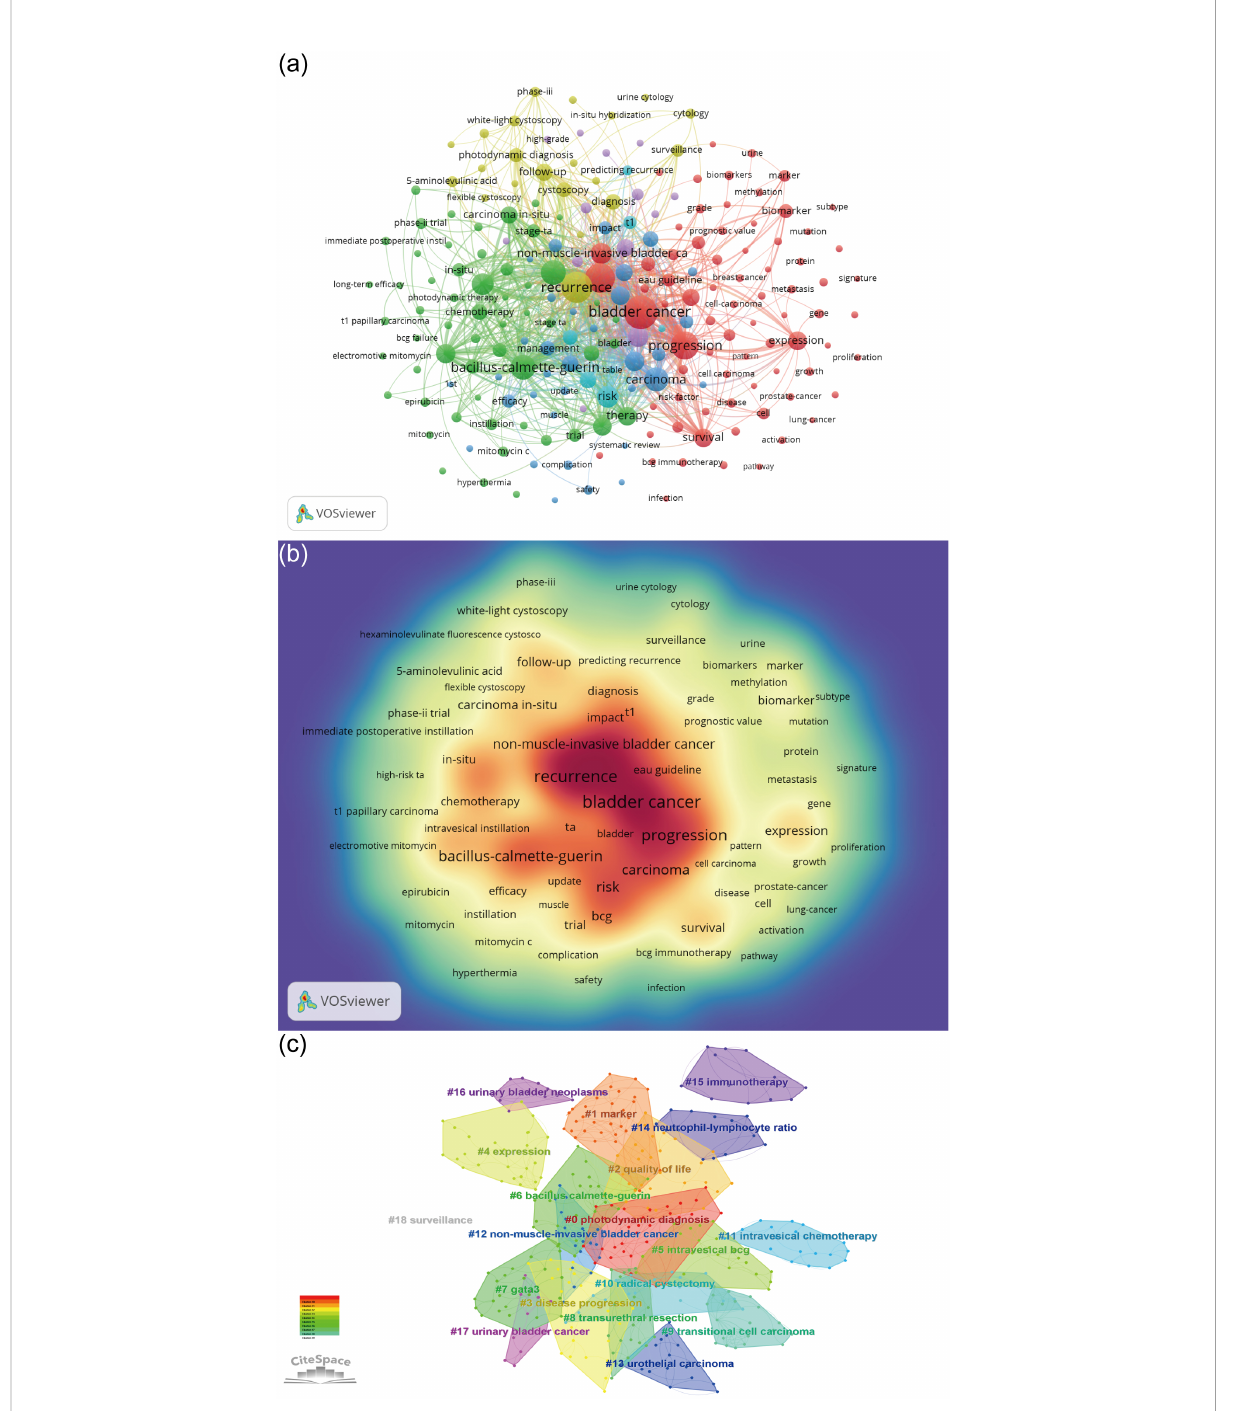
FIGURE 8 Keyword Analysis. (A) Keyword co-occurrence analysis map obtained using VOSviewer. The size of the nodes represents the number of occurrences; the thickness of the curve represents the strength of collaboration; the different colors represent the different clusters. (B) Keyword density visualization analysis. The higher the intensity of the red color node, the higher the number of keywords. (C) Keyword clustering map analysis through CiteSpace. A total of 19 categories of keywords were obtained. The different color blocks represent different keyword